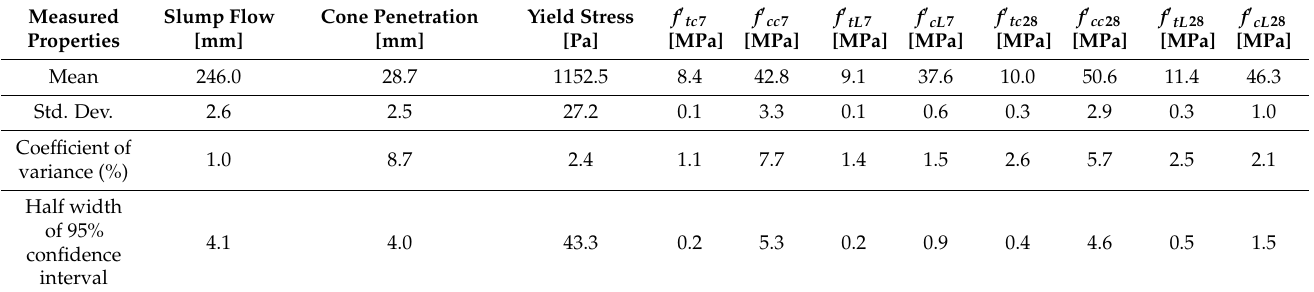
Table 6. Repeatability of test parameters at the central